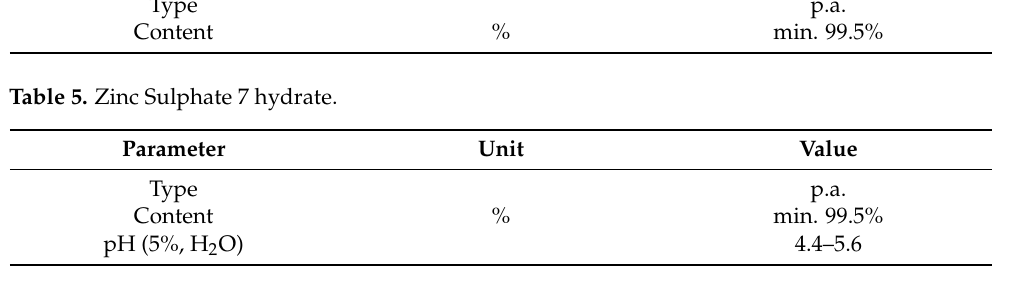
Table 6. Manganu (II) siracha 1